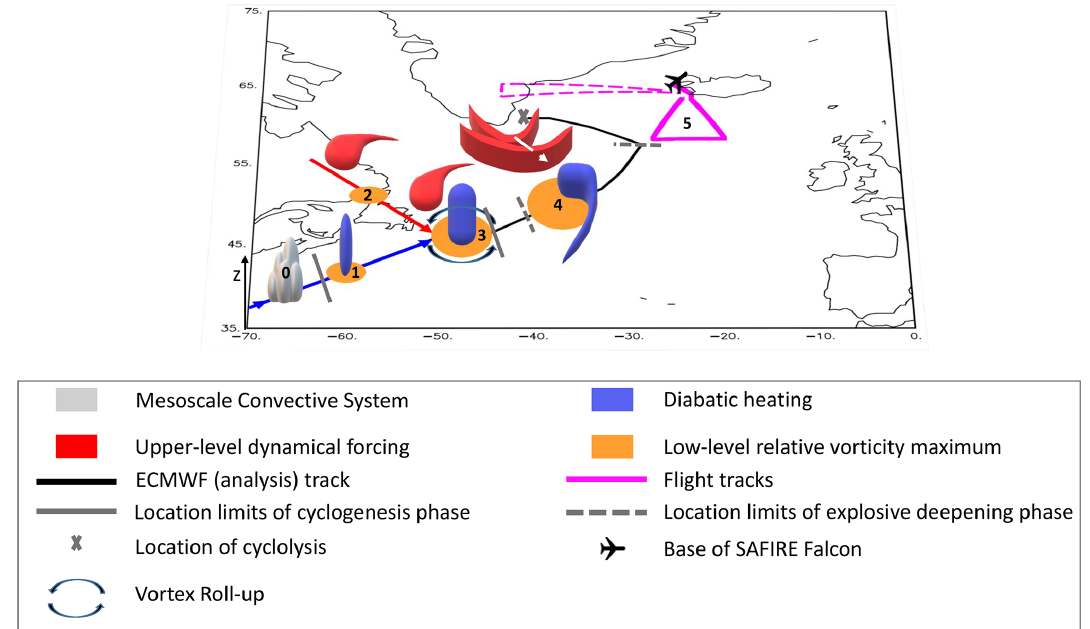
Figure 13. A schematic of the Stalactite cyclone. The mesoscale convective system (0) that initiates the diabatic Rossby vortex (1) that travels along the blue arrow. The northern precursor (2) with upper-level PV cut-off that moves towards the diabatic Rossby vortex and initiates a roll-up between the two precursors at cyclogenesis to create the Stalactite cyclone (3). Explosive deepening occurs as a result of strong diabatic heating throughout the column and the interaction with a series of embedded upper-level high-PV regions (the upper-level forcing here is depicted in the form of successive troughs in geopotential height moving in the direction of the white arrow; 4). Flight observations (5) indicate that ice water content is underestimated and so could have impacts on the diabatic heating and evolution of the